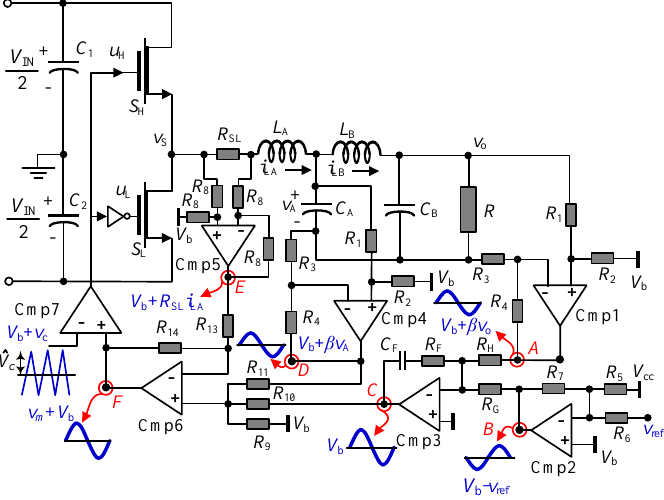
Figure 4. Circuit realization of FFDISM controller with i LA feedback (CNRL1). Energies 2018 , 9 , x FOR PEER REVIEW